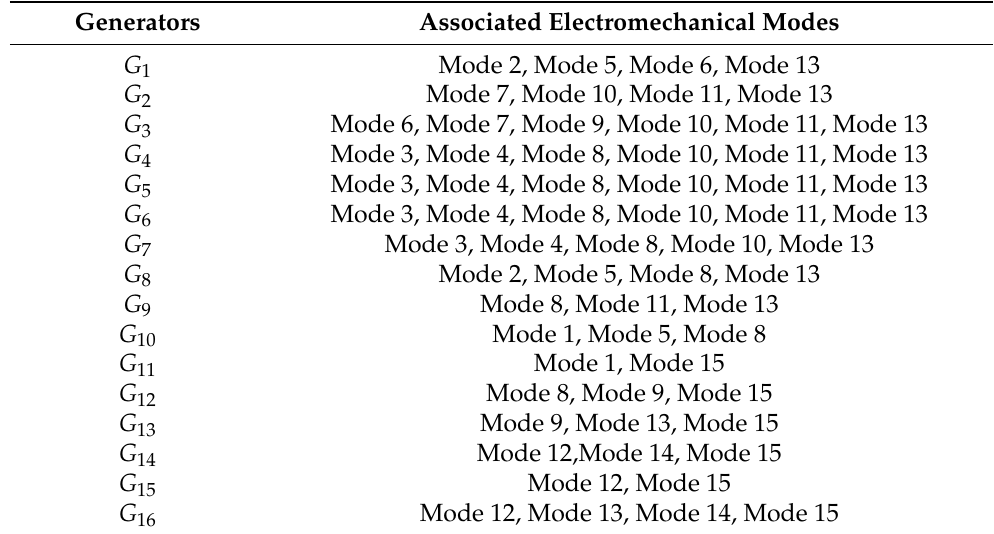
Table 1. Generators with the associated electromechanical modes from the Figure 3.